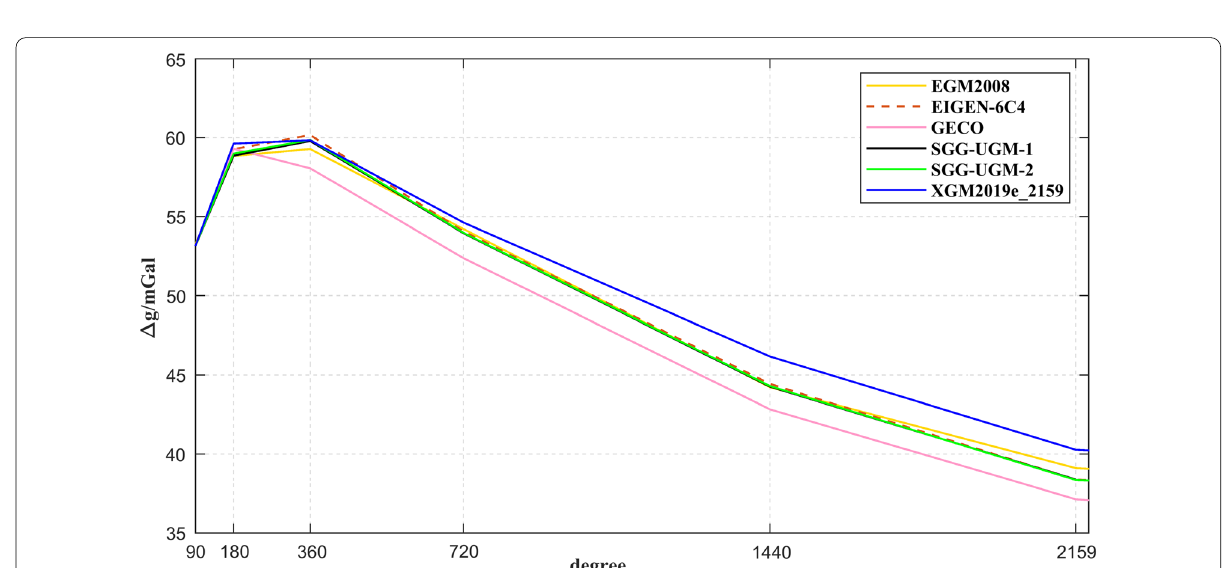
Fig. 3 The standard deviation of differences in the plateau